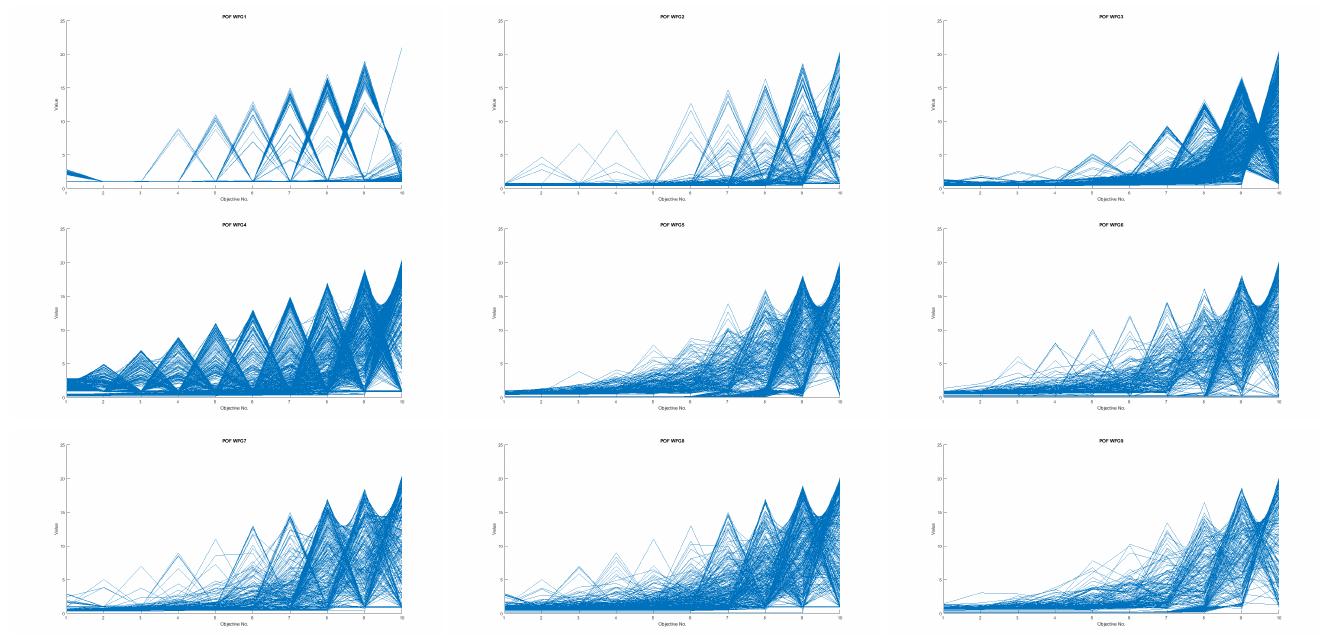
Figure 14. The plots of POF for WFG1-9 functions with 10 objectives using DB-CSA algorithm.